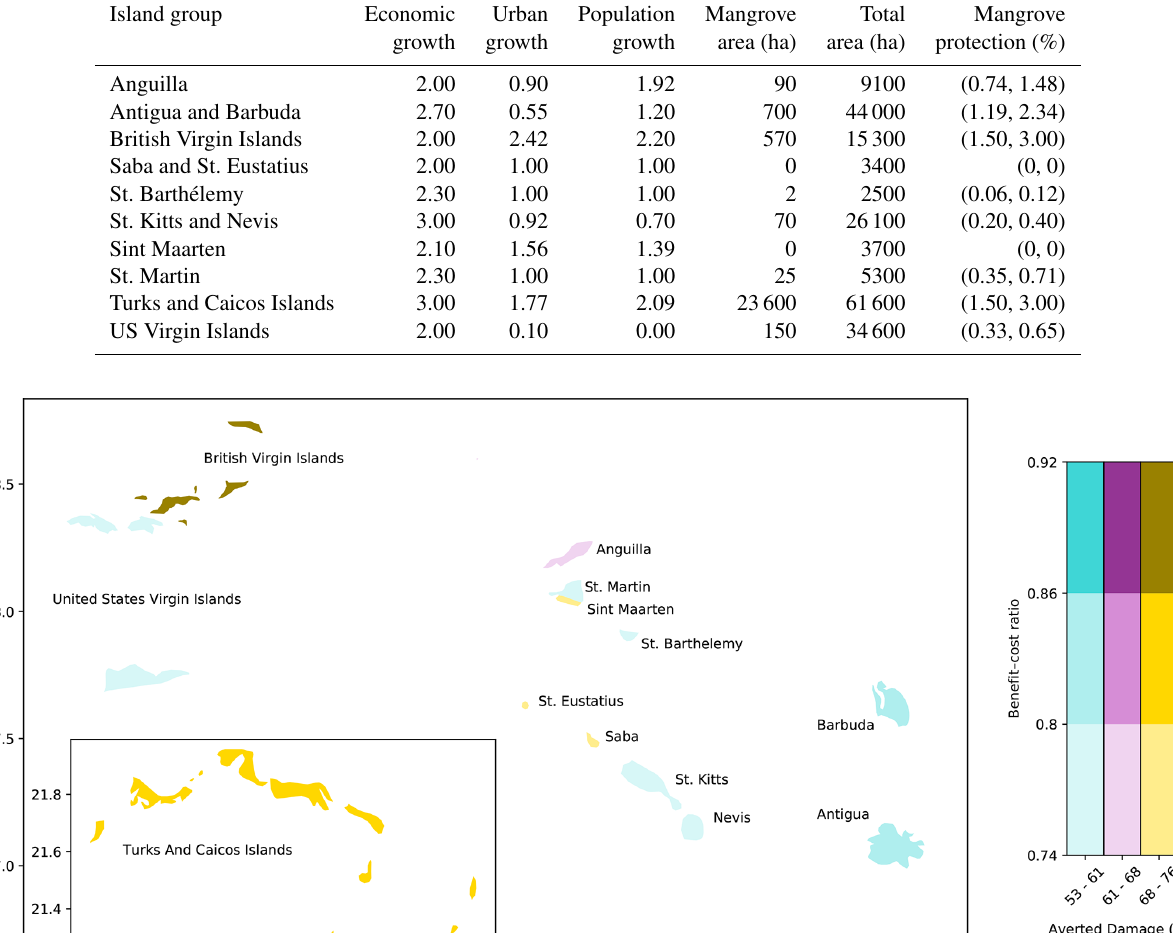
Table 1. Economic and environmental indicators used in the cost and benefit analysis of adaptation measures per island group. Mangrove protection refers to the percentage of intensity reduced on the cost and in the inland, respectively. The mangrove area (in hectares, ha) is extracted from Food and Agriculture Organization of the United Nations (2007) and the indicators from Central Intelligence Agency (2019).